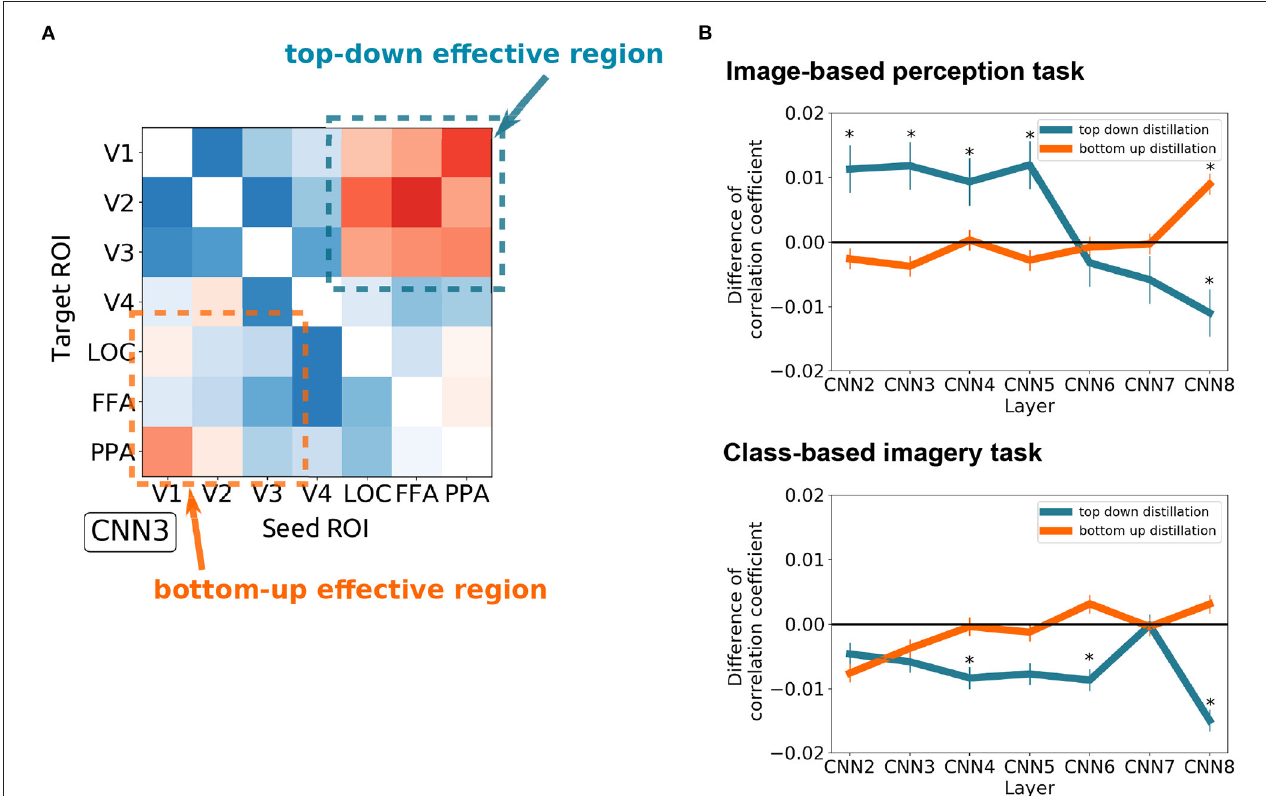
FIGURE 5 | The difference between the top-down distillation and bottom-up distillation. (A) An example of the CNN3 ’s effect matrix illustrating the measured regions. The mean of the 3 × 3 squares at the upper right and lower left of the effect matrices were measured. (B) The variance of the two kinds of distillation as the feature complexity increases (from CNN2 to CNN8) in case of image-based perception task (upper) and class-based imagery task (lower). Error bars represent SEM. * p < 0.05 after Bonferroni correction for multiple comparisons ( FWE < 5 % ); two sided one sample t -test after Fisher’s z-transform.